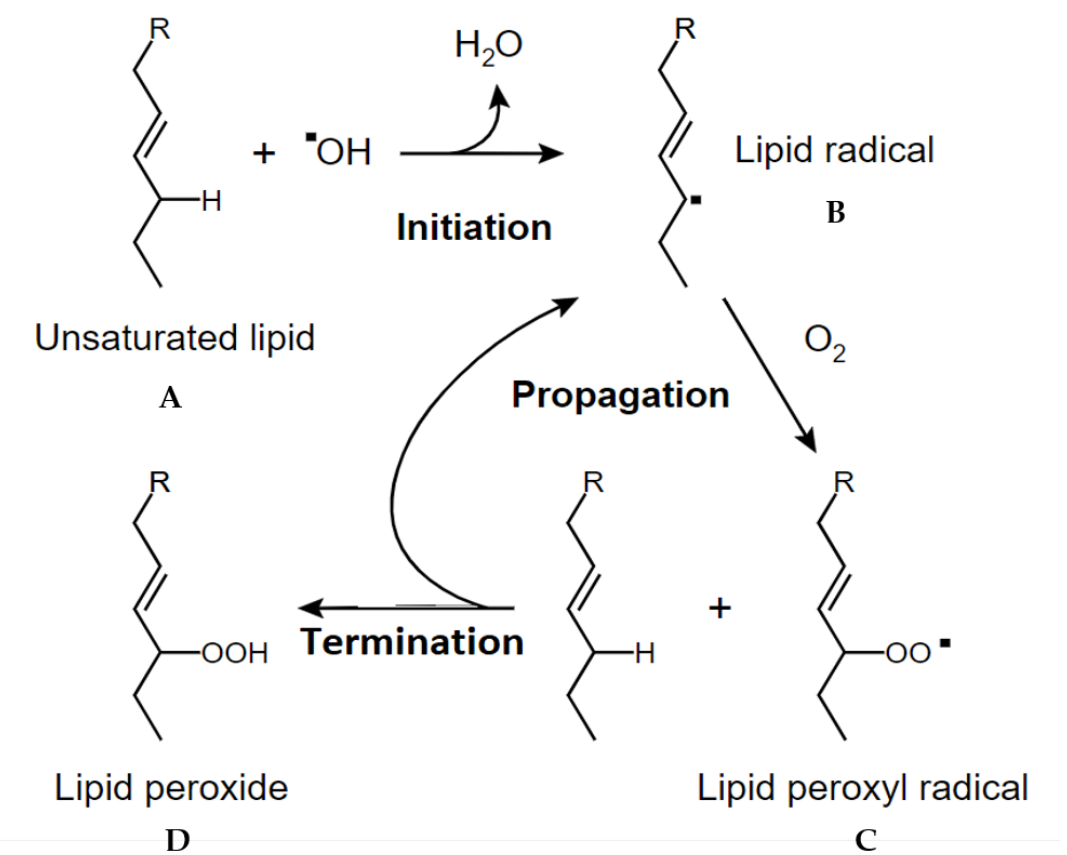
Figure 6. Mechanism of lipid peroxidation. ( A ) Unsaturated lipid; ( B ) radical lipid; ( C ) lipid peroxyl radical; ( D ) lipid